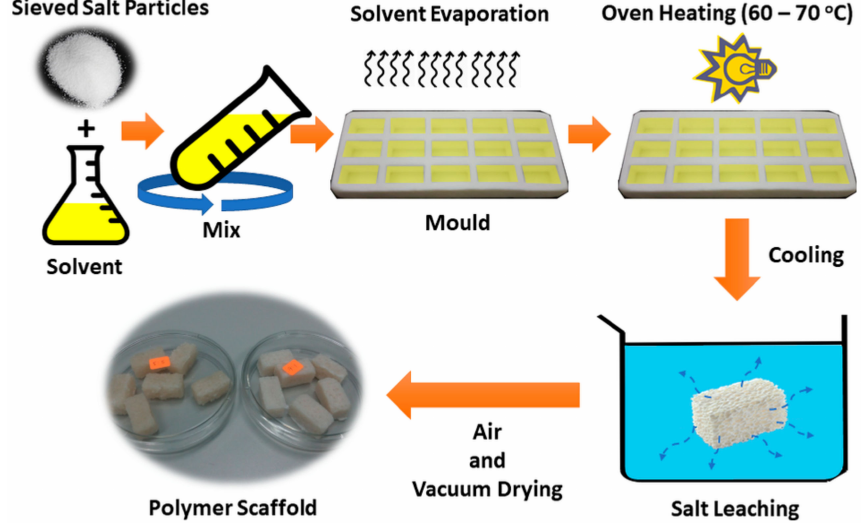
Figure 2. Schematic diagram for solvent casting and particulate leaching